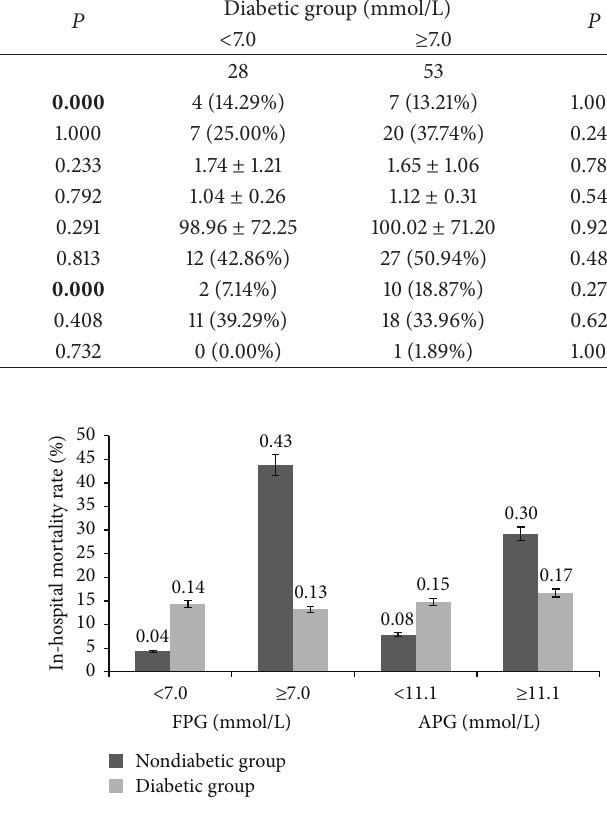
Figure 1: The relationship between blood glucose level and in- hospital mortality rate.